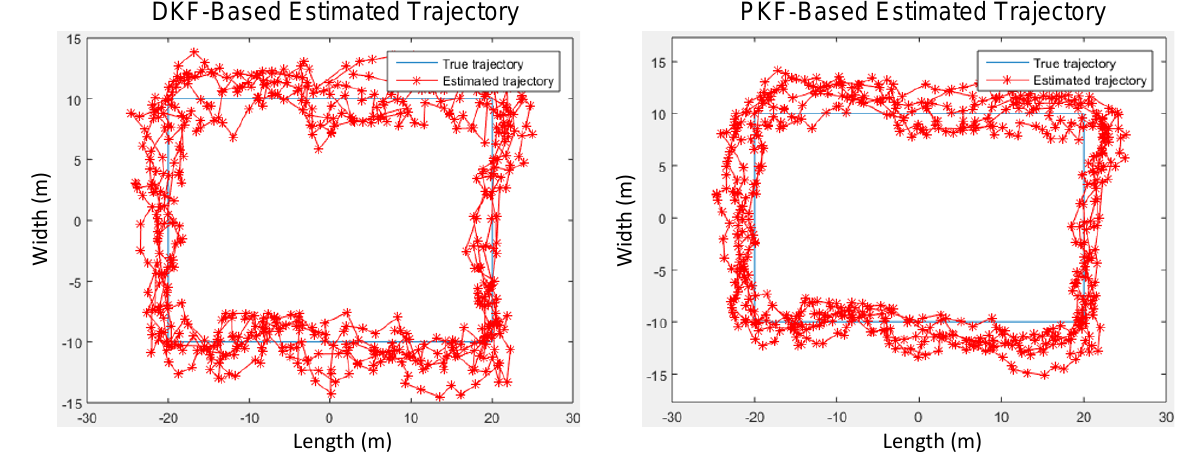
Figure 5. Under the same large variance environment, use DKF and PKF individually.